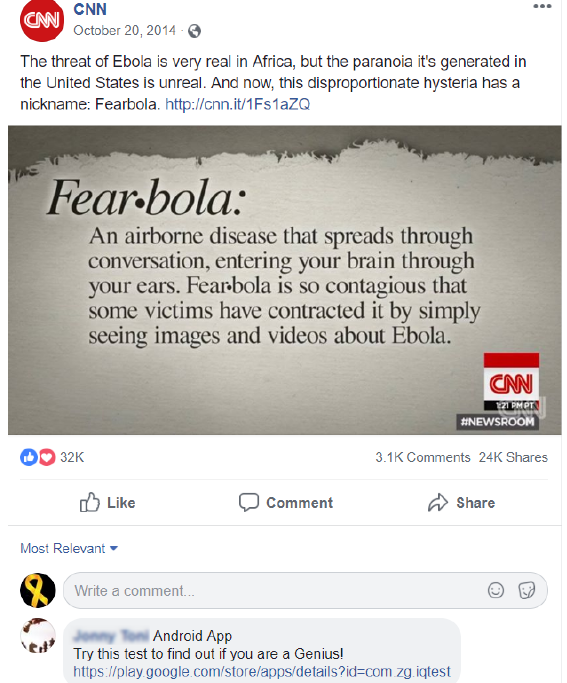
Figure 1. Android apps download links posted to an article about the threat of Ebola.